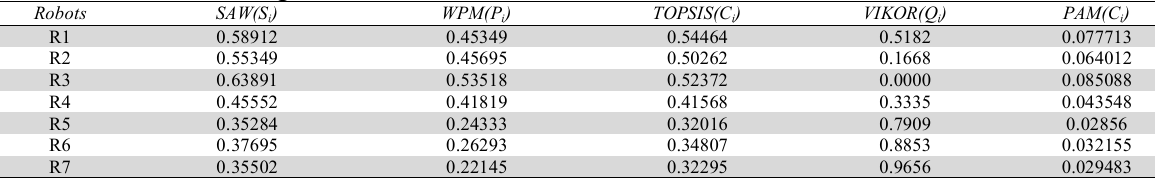
Performance scores using MADM